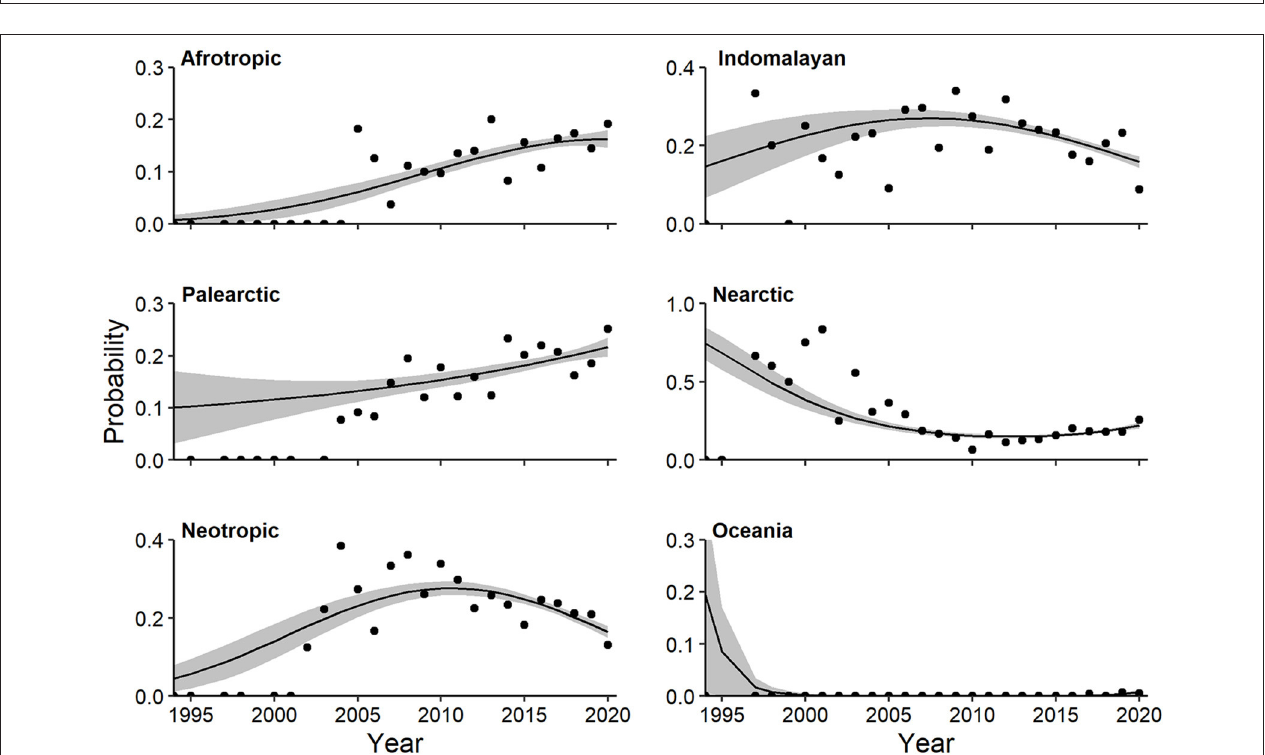
FIGURE 11 | Multivariate regression effects plot of realms exhibiting temporal trends ( P < 0.10). Shaded regions represent standard errors and points represent observed annual